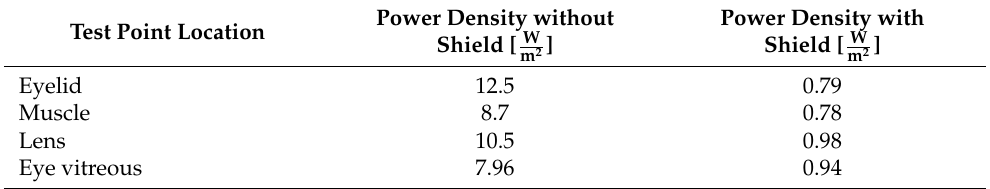
Figure 16. Power density distribution with shield (horizontal polarization); reference value 0 dB = 40 W/m 2 . The regions in the circle are the areas of the eye. Table 6. Poynting vector for the model with and without shield, vertical